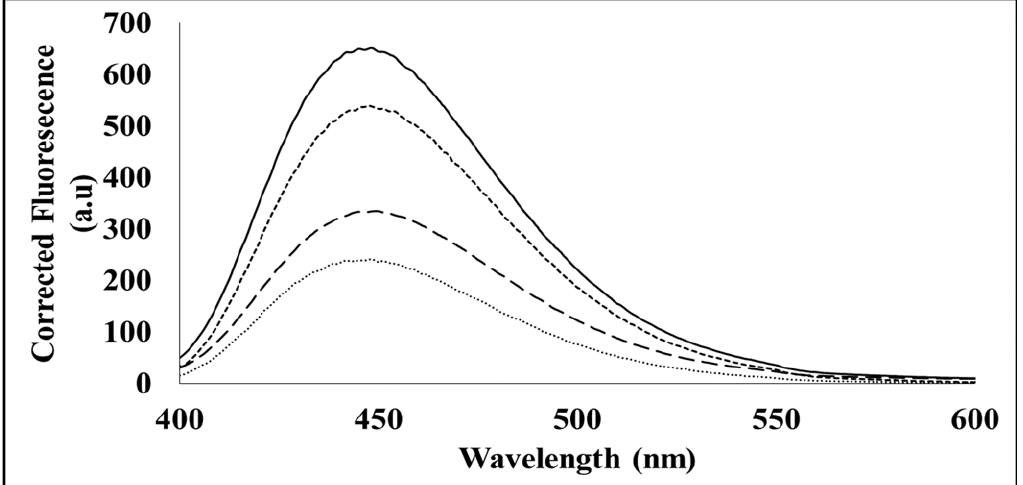
Figure 5. Extrinsic MANT- ATP fluorescence spectra of 100 µm MANT ATP (long dashes) bound to 10 µm MP (short dashes), 8 M urea (solid line), and 10 µm MP + 8 M urea (star dashes). 10 µ m MP (short dashes), 8 M urea (solid line), and 10 µ m MP + 8 M urea (star